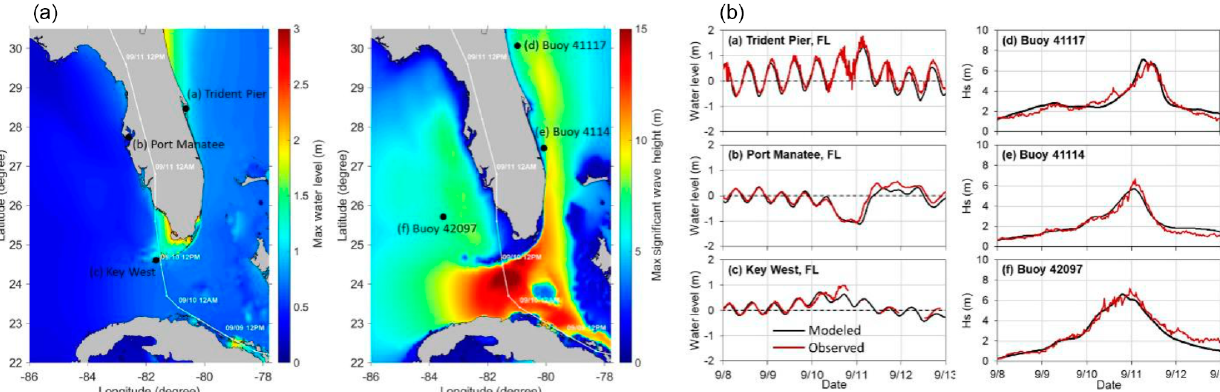
Figure 1. Hydrodynamic modeling of water level and wave height for Hurricane Irma. Panel (a) shows spatial distribution of modeled maximum water level and significant wave height, respectively. White curve represents storm track. Black points show locations of available tidal gauge and buoy stations. Red point indicates approximate location of study area. Panel (b) compares observed and modeled time series of water level and significant wave height ( H s ), respectively.